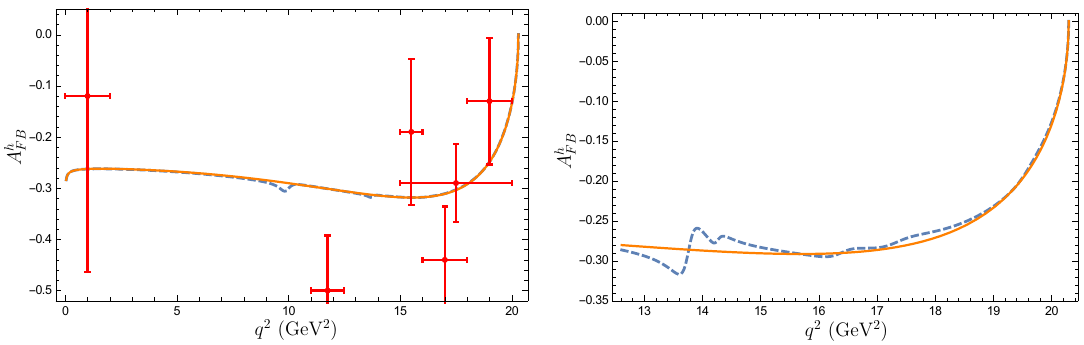
Λ µ + µ ( q 2 ) in the Λ b − FB →